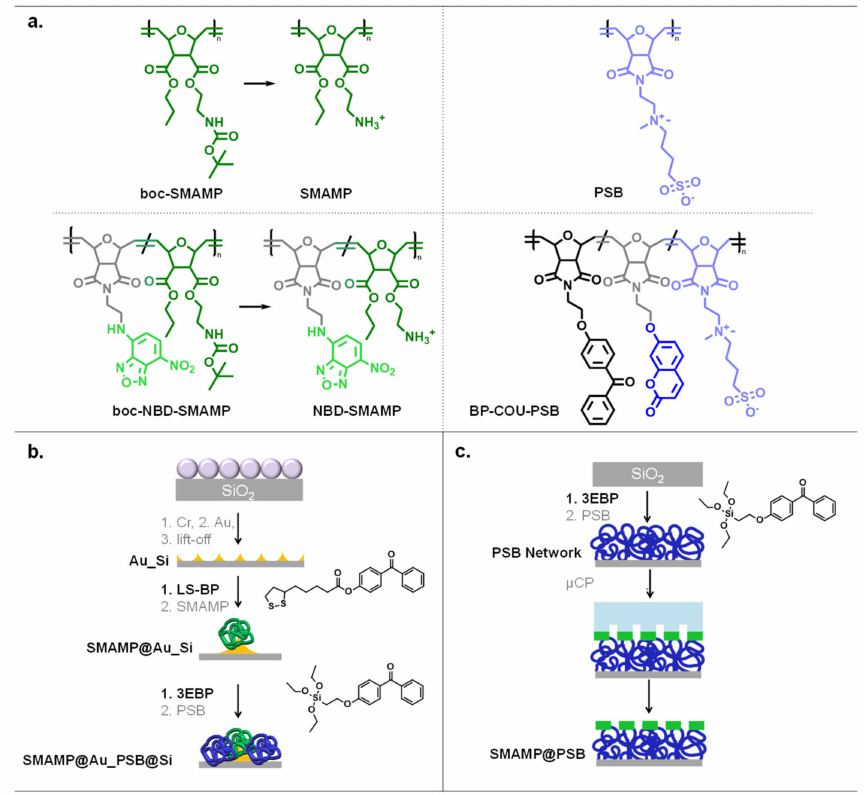
Figure 1. ( a ) Polymers used: boc-SMAMP and PSB for CL; boc-NBD-SMAMP and BP-COU-PSB for µ CP. The boc protective groups were removed after the structuring process to obtain active SMAMP groups. ( b ) CL fabrication process. A monolayer was formed from polystyrene colloids (2 µ m) on a silicon wafer and used as a lithographic mask, through which chromium and gold were evaporated. After mask removal, the gold islands (yellow) were functionalized with lipoic acid disulfide benzophenone ( LS-BP ) and boc-SMAMP (green). Treatment with HCl activated the SMAMP. The silicon background was functionalized with triethoxy benzophenone silane ( 3EBP ) PSB (blue). ( c ) µ CP fabrication process: A silicon wafer was functionalized with 3EBP followed by immobilization of the PSB network (blue, made from BP-COU-PSB ). boc-NBD-SMAMP (green) was printed onto the network using a PDMS stamp (light blue). The printed boc-NBD-SMAMP pattern was surface-attached by UV-irradiation ( λ = 254 nm, energy = 3 J cm − 2 ), giving SMAMP@PSB after removal of the boc protective groups with